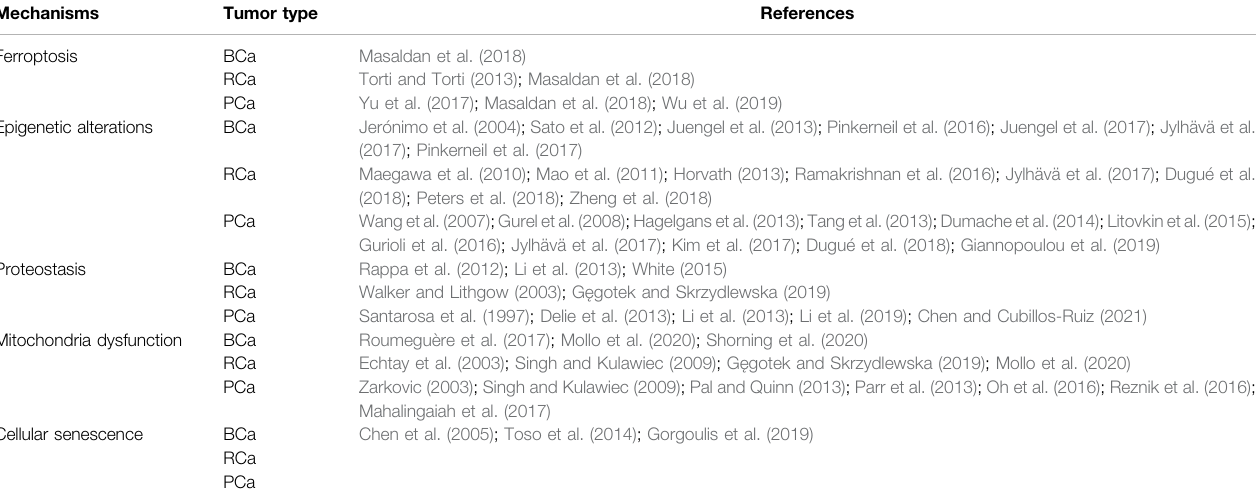
TABLE 1 | The effects of ALDH2 on urological cancers in this